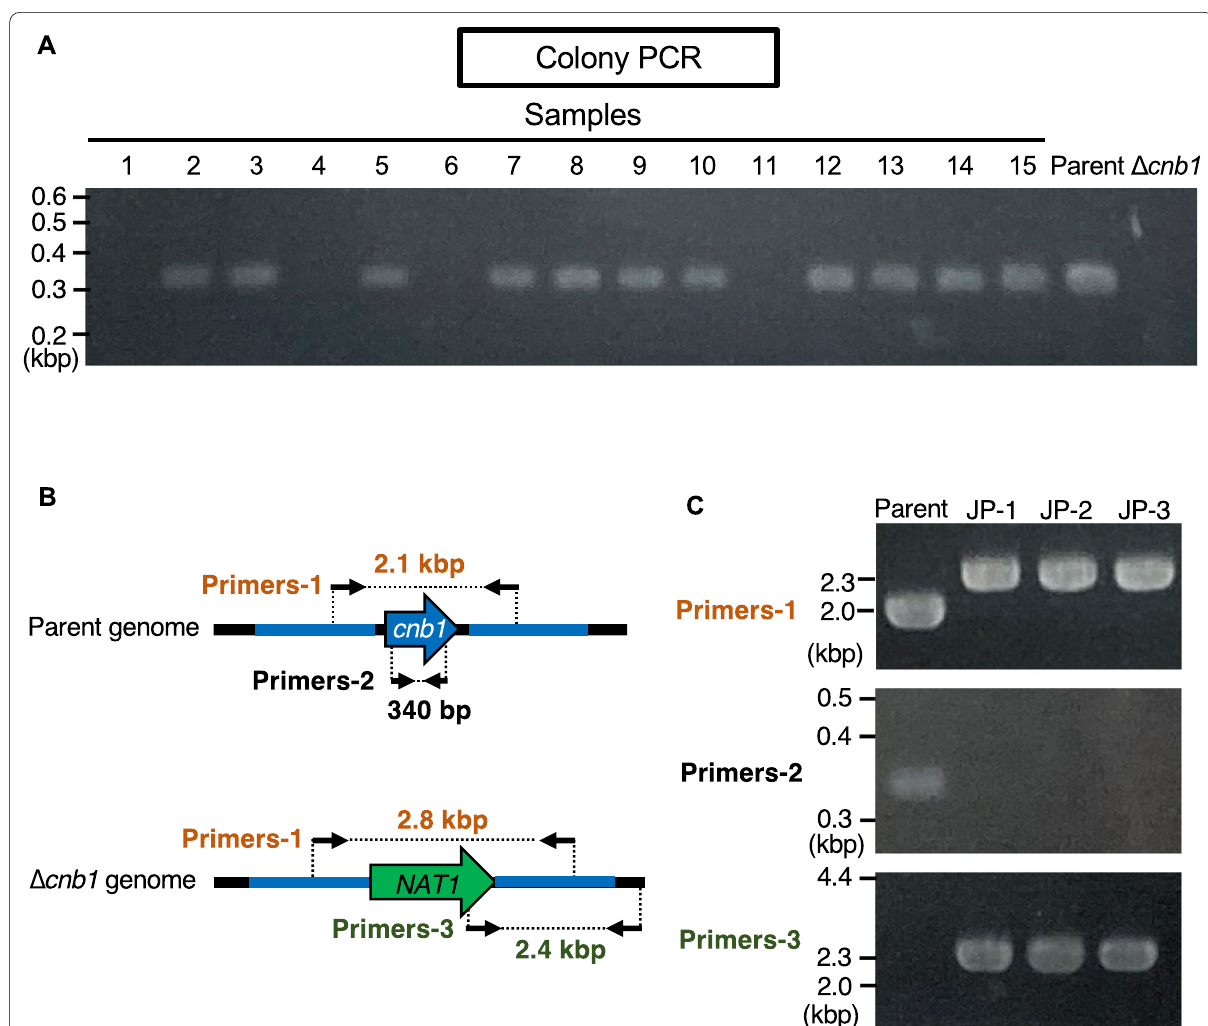
Fig. 5 Generation of cnb1 gene-deficient mutant using DNA fragment produced by joint PCR. A DNA fragment 2 produced by joint PCR was added to competent T. asahii cells prepared by culture for 1 day and electroporated (time constant protocol: 1.8 kV, 5 ms). Colony PCR was performed on colonies (samples 1–15) grown on SDA containing nourseothricin (300 µg/ml). B Location of the primers for confirming the genome structure of the cnb1 gene-deficient candidate by PCR. C Confirmation of the cnb1 gene-deficiency of the cnb1 gene-deficient candidate by PCR using extracted genome DNA